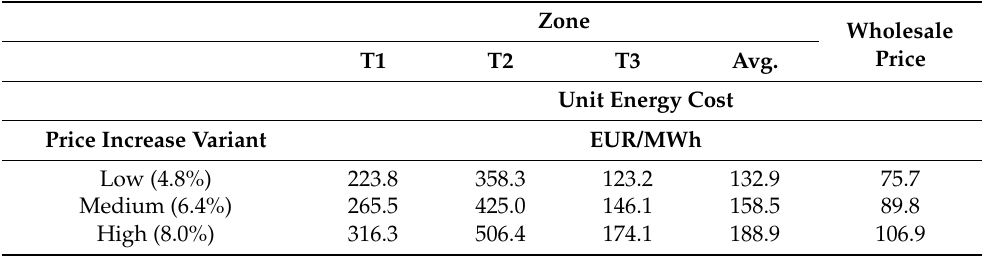
Table 3. Calculated 20-year average price of energy for 3 variants of price increase.